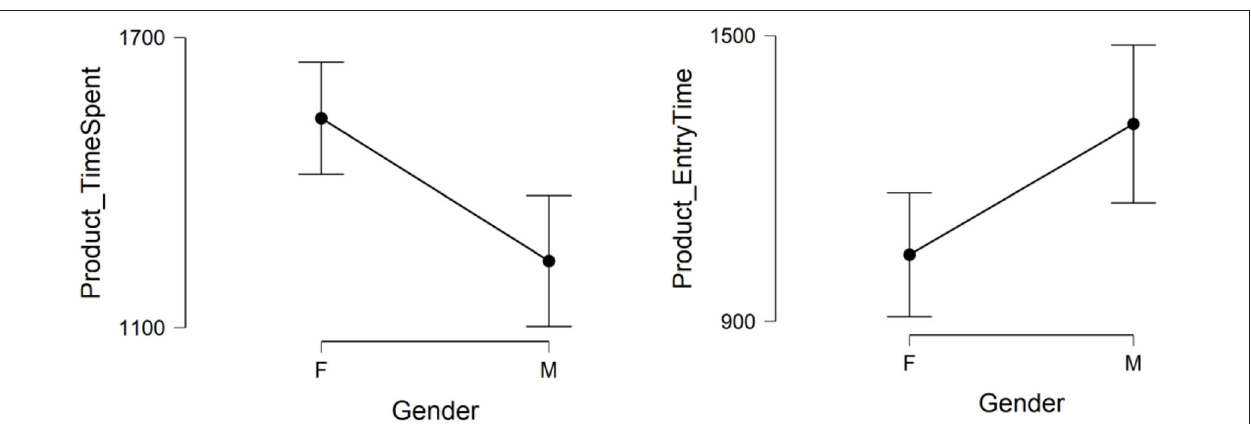
FIGURE 4 | Plot 4 – product time spent, product entry time/gender